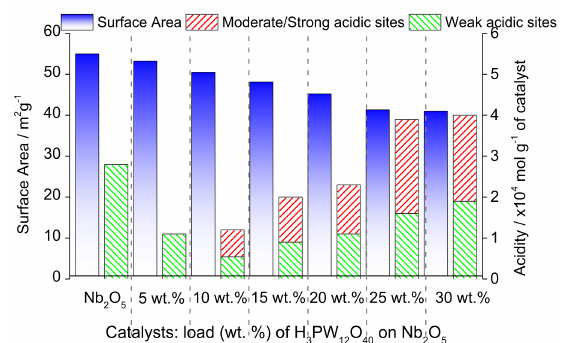
Figure 25. Relationship between the increase in H 3 PW 12 O 40 load, surface area, and acidity strength of the catalysts (loadings from 5 to 30 wt%) (adapted from